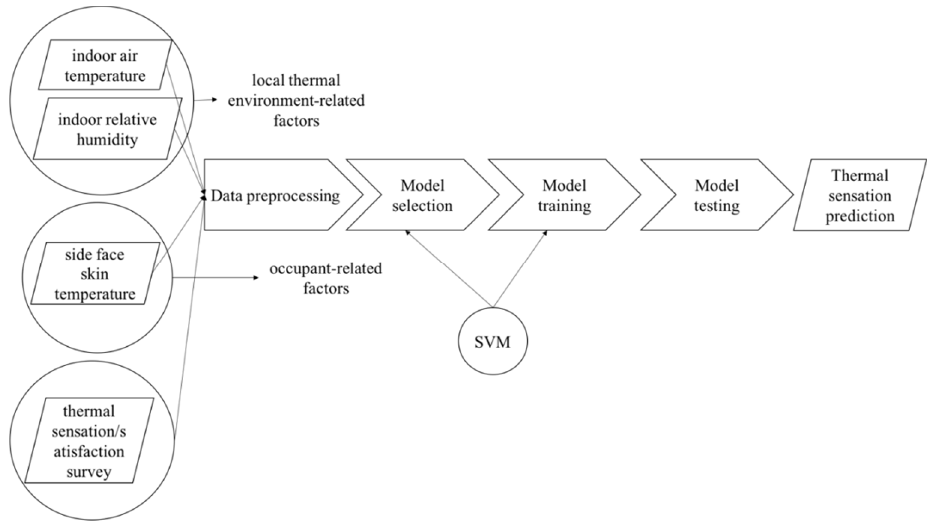
Figure 5. Personal thermal comfort metrics. ( a ) The 7-point thermal sensation; ( b ) 5-point thermal satisfaction.